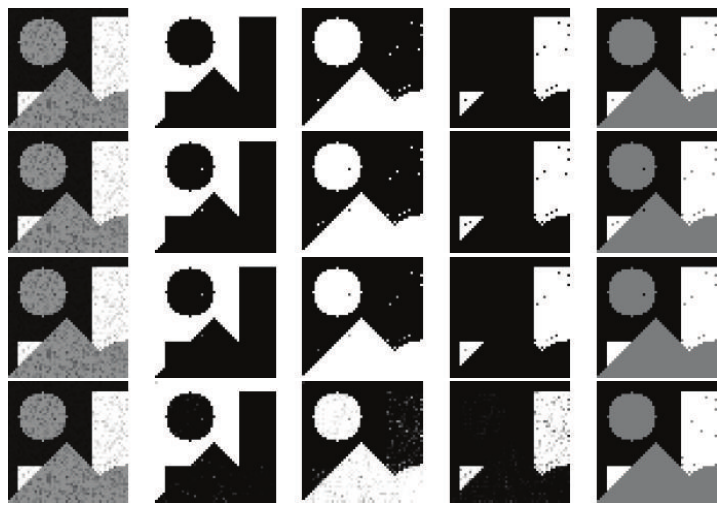
Figure 3: Comparison between variances fixed and updated. In every row, the first three graphs are membership functions, and the forth is the hard segmentation after thresholding. Row 1: result with 𝜎 = 0.005 , Row 2: result with 𝜎 = 0.010 , Row 3: result with 𝜎 = 0.015 , Row 4: result with 𝜎 = 0.020 , and Row 5: result with 𝜎 updated.